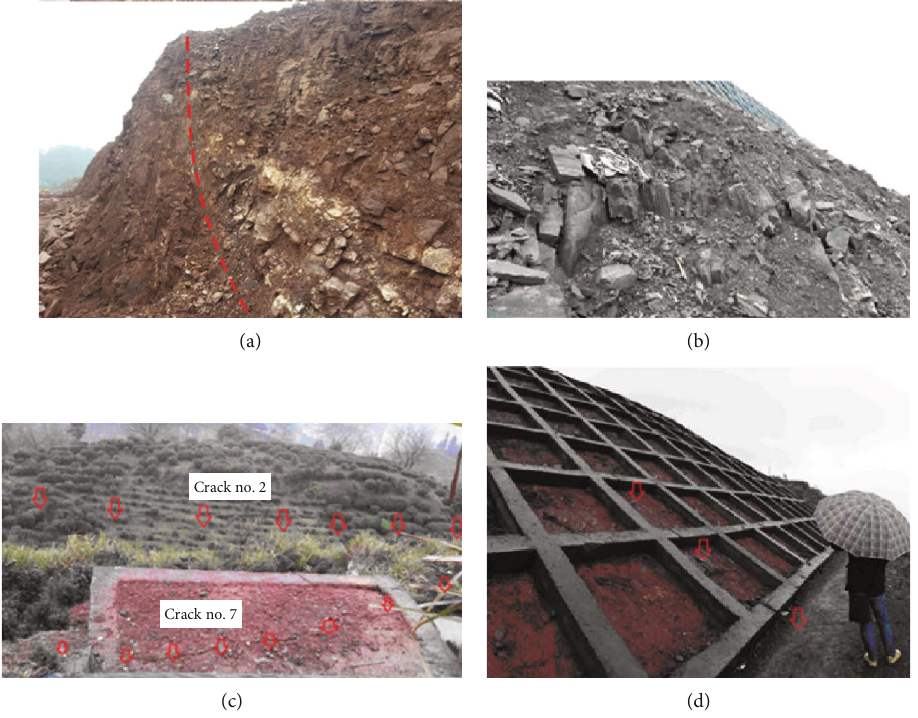
Figure 2: Deformation and cracks: (a) excavation reveals of the faults, (b) slope foot uplift, (c) main deformation crack, and (d) main deformation cracks of grid